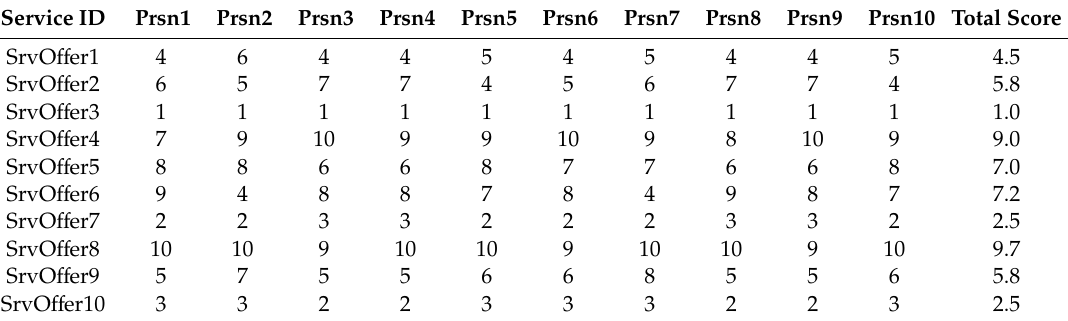
Table 7. Human response on